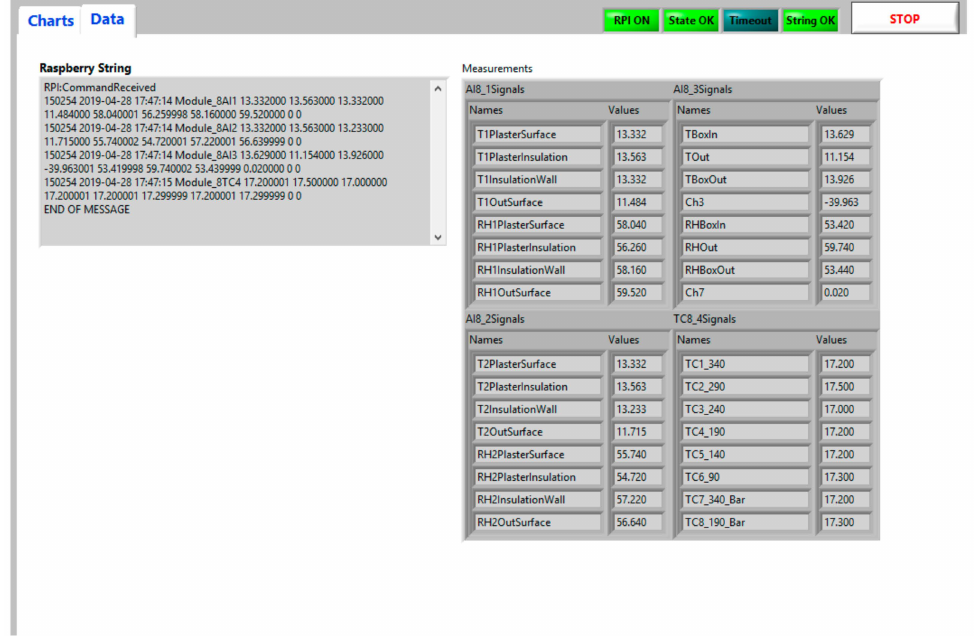
Figure 11. Data overview software: Data section. It permits to see raw data from the acquisition cards to clearly understand the behavior of the entire system in case of problems. Upper indicators clearly show the communication status showing the status of the line with raspberry and the correctness of the received